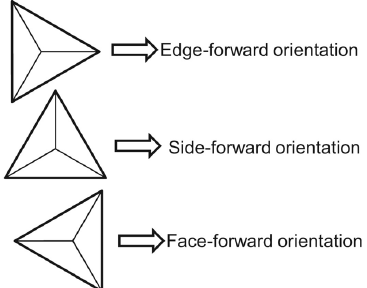
Figure 2: Schematic representation of the Berkovich indenter: dif- ferent tip orientations, including edge-forward, side-forward and face-forward